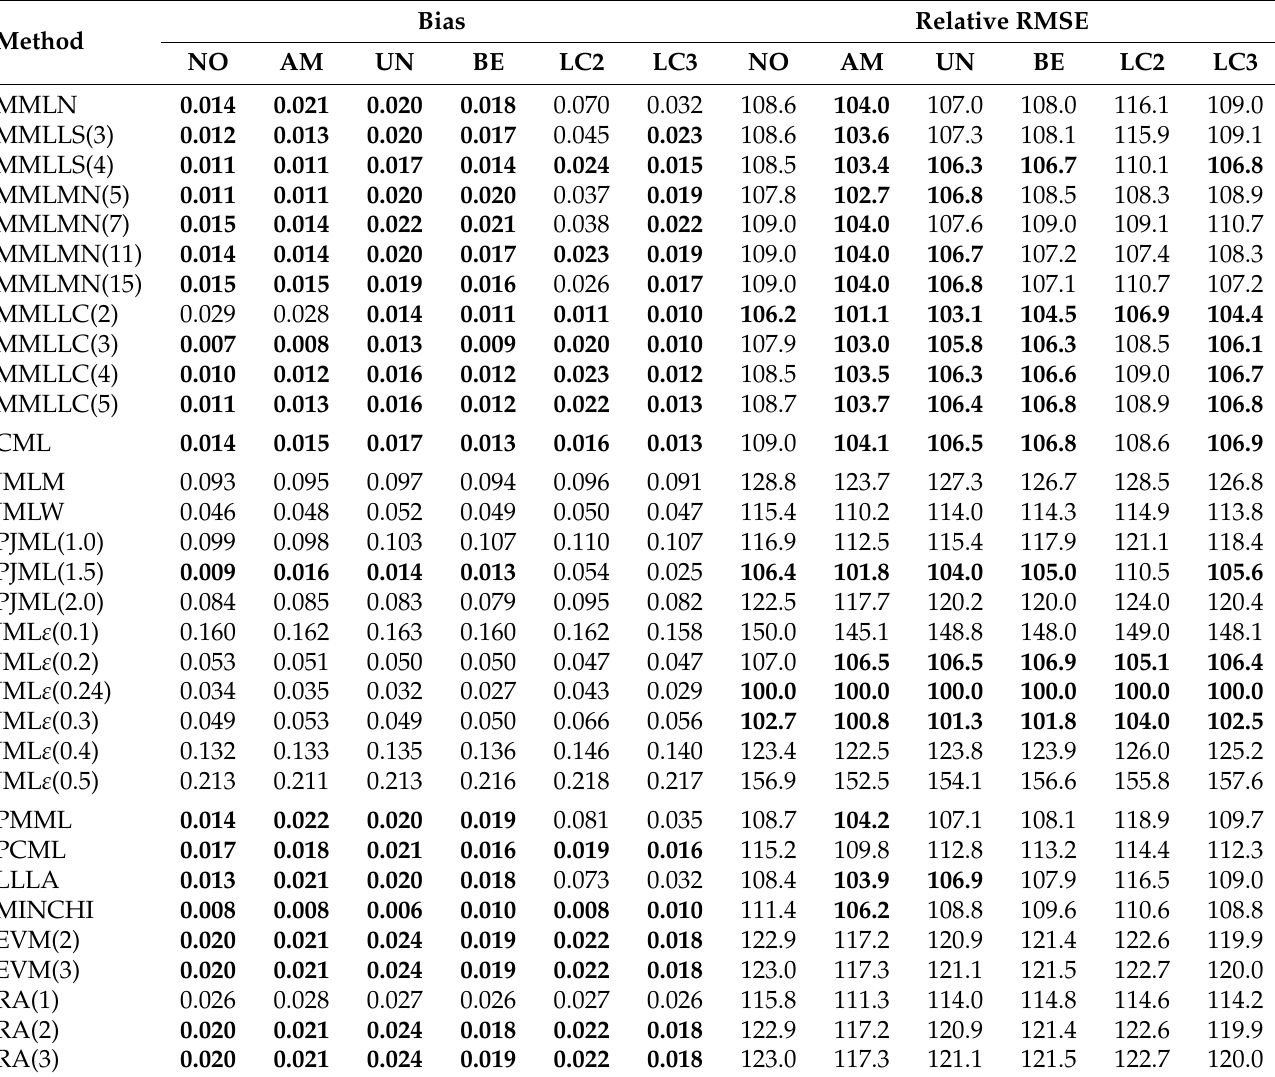
Table A2. Bias and relative RMSE for different estimation methods for a sample size of N = 250 and I = 10 items for a test with a wide range of symmetrically distributed item difficulties as a function of the data-generating trait